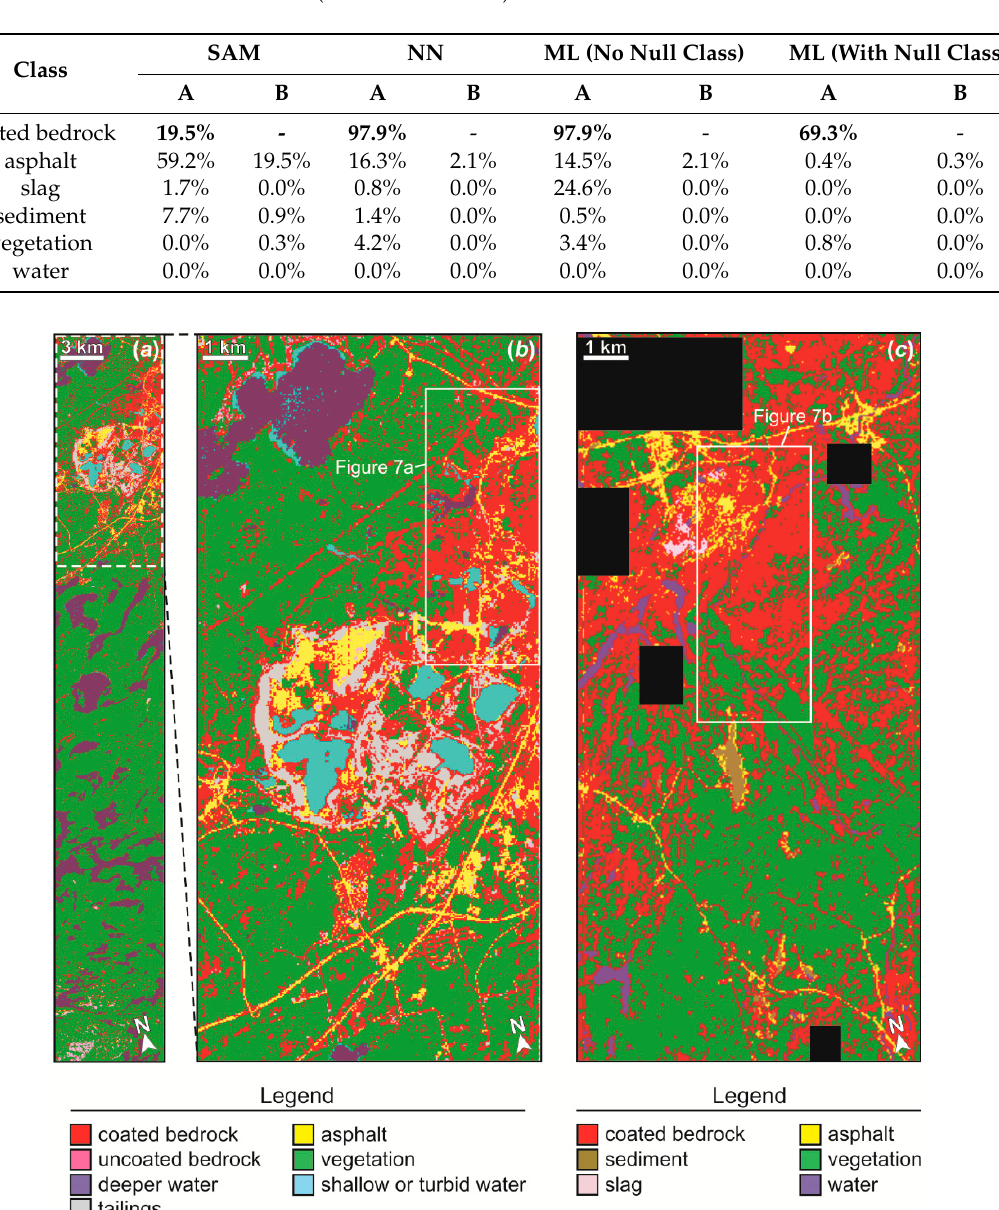
Figure 11. Maps of black coatings and other classes of interest for areas near the Copper Cliff ( a and b ) and Coniston ( c ) smelters, based on maximum likelihood classification (no null class) of the nine-channel multispectral databases generated from Hyperion images. Areas affected by cloud cover in the Coniston study area are masked by black rectangles. Image footprints and smelter stack locations are given in Figure 1. Selected lakes and other landmarks are labeled in Figures 6 and 7.